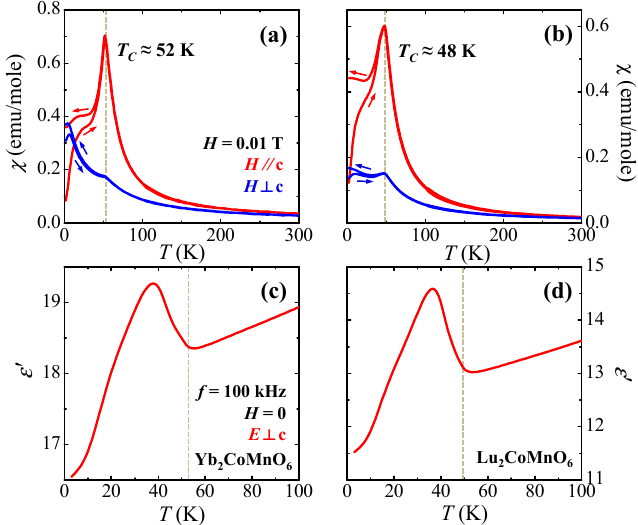
Figure 4 . Temperature dependence of magnetic susceptibility, χ = M/H (1 emu = 4 π × 10 − 6 m 3 ), for YCMO ( a ) and LCMO ( b ) single crystals along ( H // c ) and perpendicular ( H ⊥ c ) to the c axis upon warming in H = 0.01 T after zero-magnetic-field cooling (ZFC) and upon cooling in the same field (FC). Temperature dependence of dielectric constant ( ε′ ) perpendicular to the c axis in 0 T for YCMO ( c ) and LCMO ( d ) single crystals.